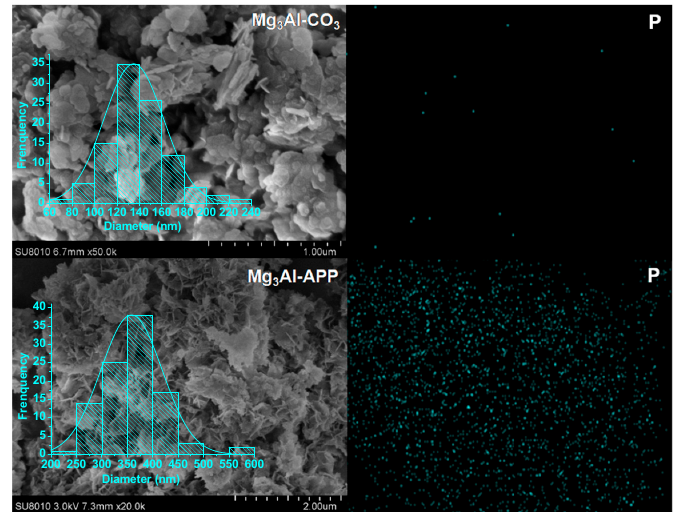
Figure 2. SEM images of Mg 3 Al-CO 3 and Mg 3 Al-APP LDH and corresponding EDS mapping of phosphorus.